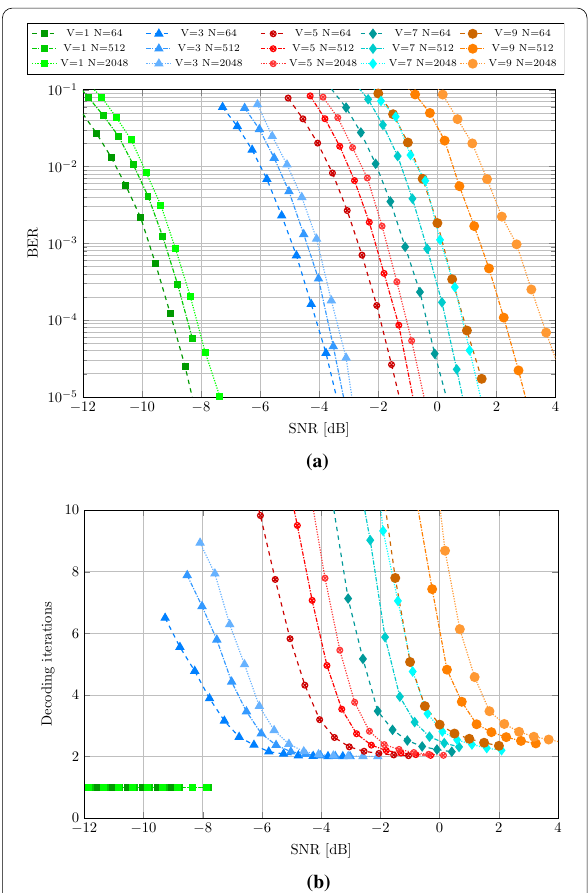
Fig. 3 BER ( a ) and number of decoding iterations ( b ) depending on the SNR for Integer-HDM with fixed D = 512 and varying number of superposed vectors V and item memory size